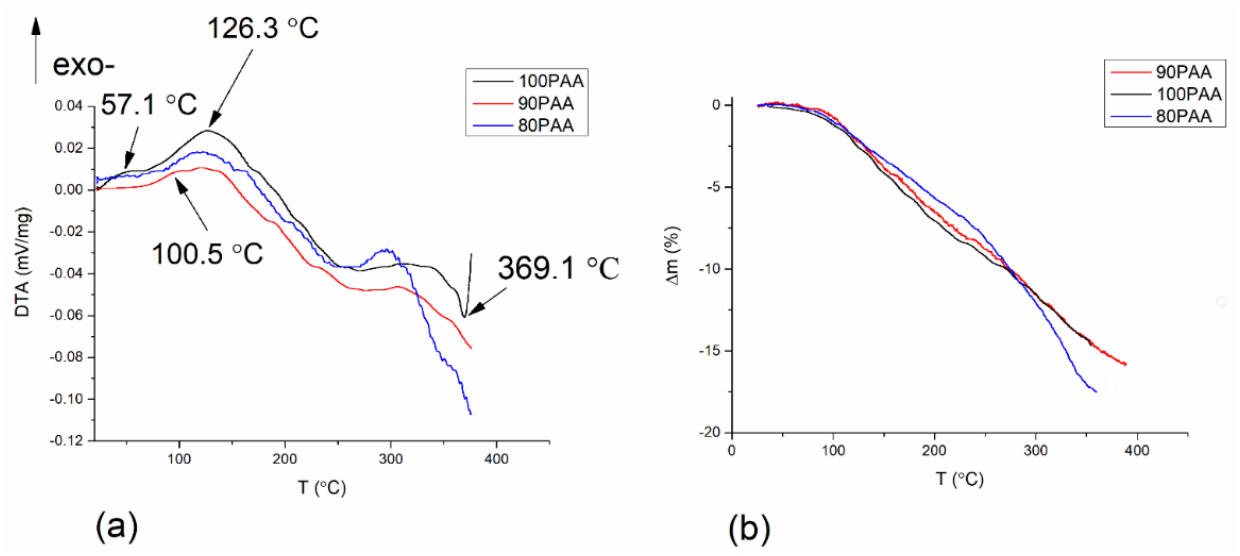
Figure 1. ( a ) DTA curves and ( b ) TG curves of 100PAA, 90PAA and 80PAA powders. Two endothermal effects at 57.1 and 126.3 ◦ C, and one exothermal effect at 369.1 ◦